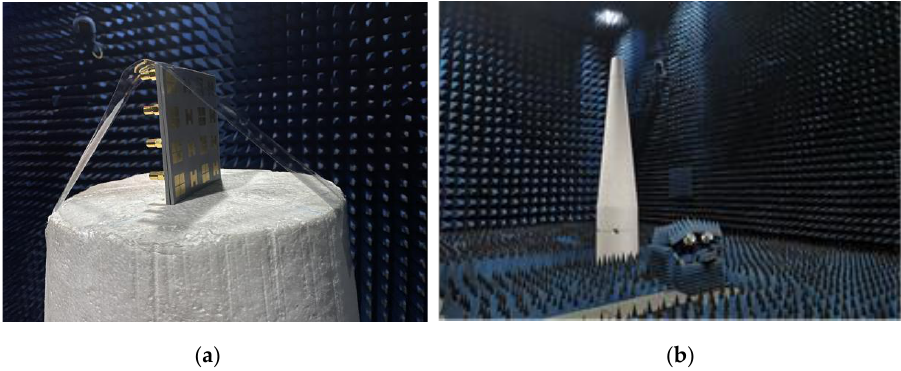
Figure 24. The RCS test scenario of the array antenna prototype. ( a ) Array antenna prototype; ( b ) the RCS test environment.